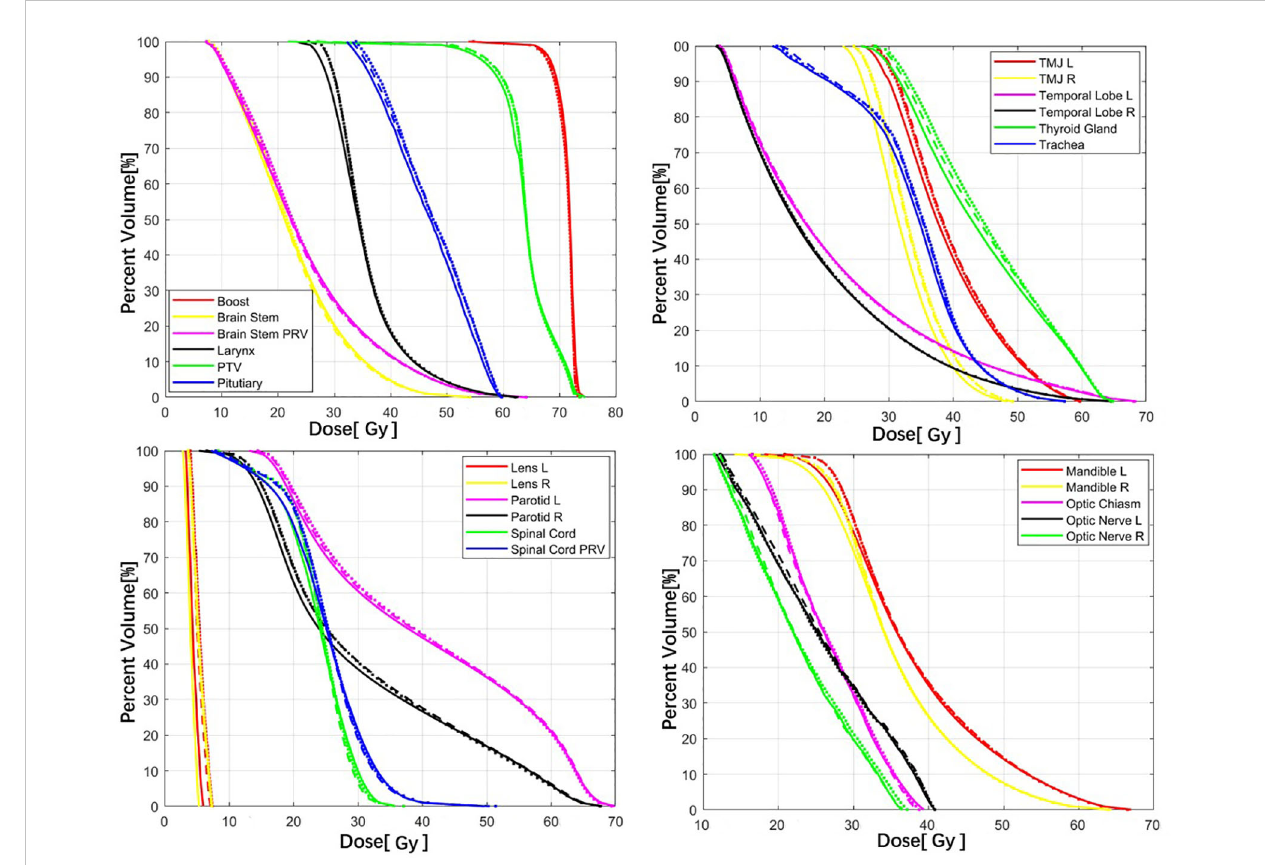
FIGURE 3 Comparison of the mean DVHs between the COM model (dash lines), ANAT model (dot lines), and GT (solid